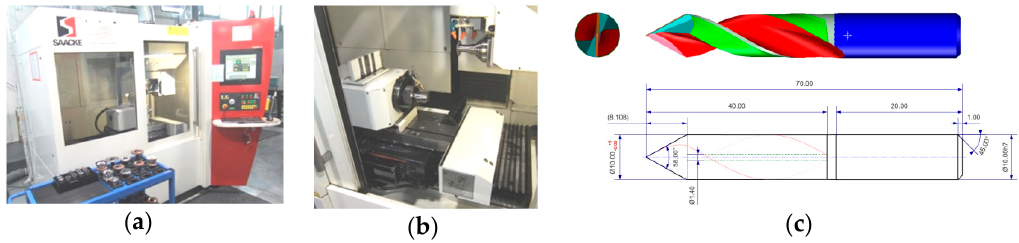
Figure 5. Grinder with drill design: ( a ) SAACKE CNC-Grinding Center Model UW I F; ( b ) work-space of the grinder; ( c ) drill design in the Numroto ® Plus program.